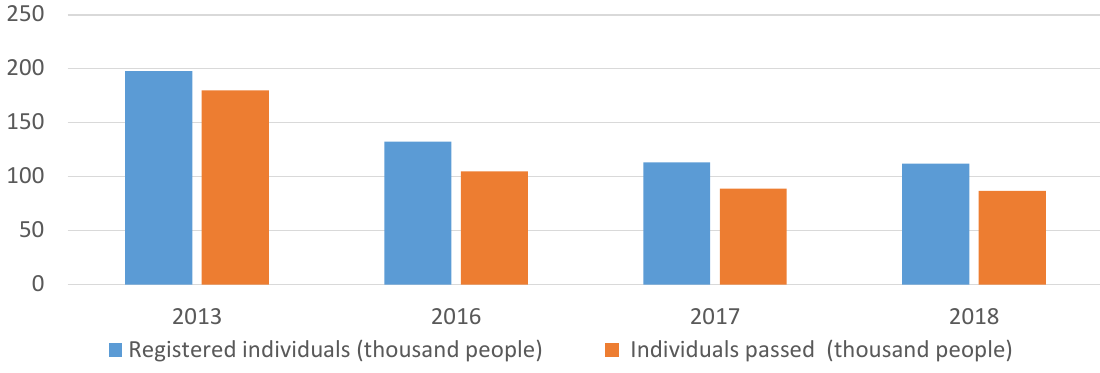
Figure 1. Dynamics of the registration and compilation of EIT in mathematics